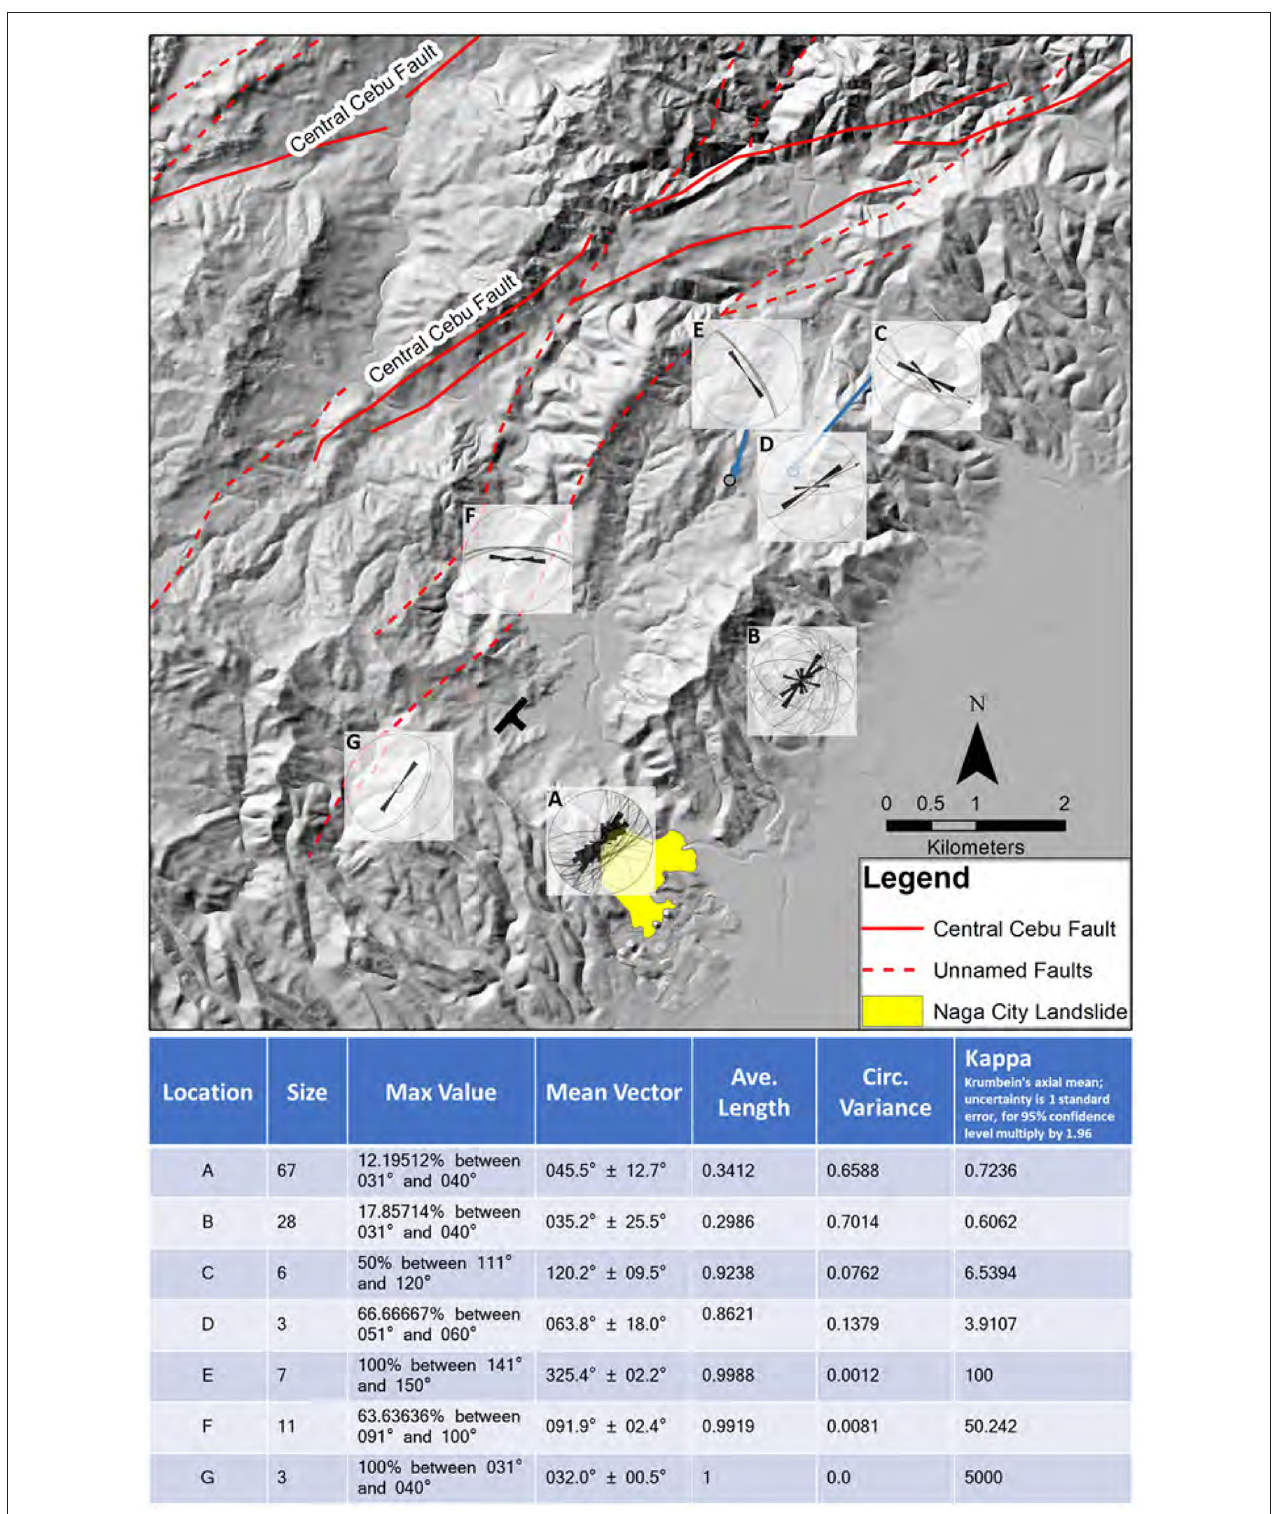
FIGURE 11 | Stereoplots and rose diagram plots of structural measurements in Naga City. Figures 10A–C found in rose diagram A. Figure 10D in rose diagram B. Figure 10E in rose diagram E. Figure 10F in rose diagram D.